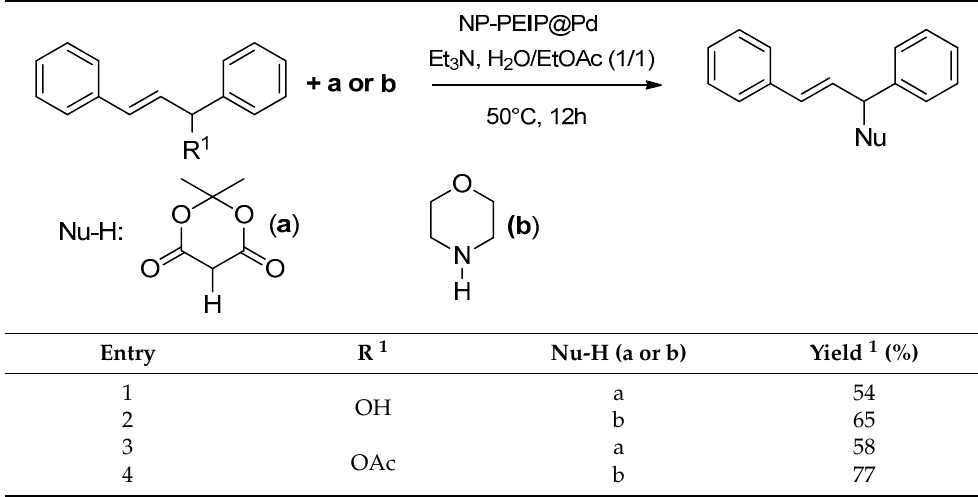
Table 4. Tsuji-Trost reactions catalyzed by NP-PEIP@Pd.